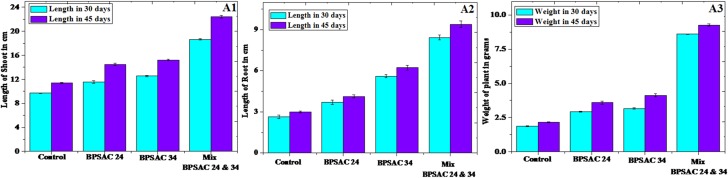
Effect of Streptomyces sp. (BPSAC34), Leifsonia xyli (BPSAC24) and combined inoculation of BPSAC 34 and BPSAC 24 on shoot length (A1), root length (A2) and plant total weight (A3) on chilli seedlings in greenhouse conditions.